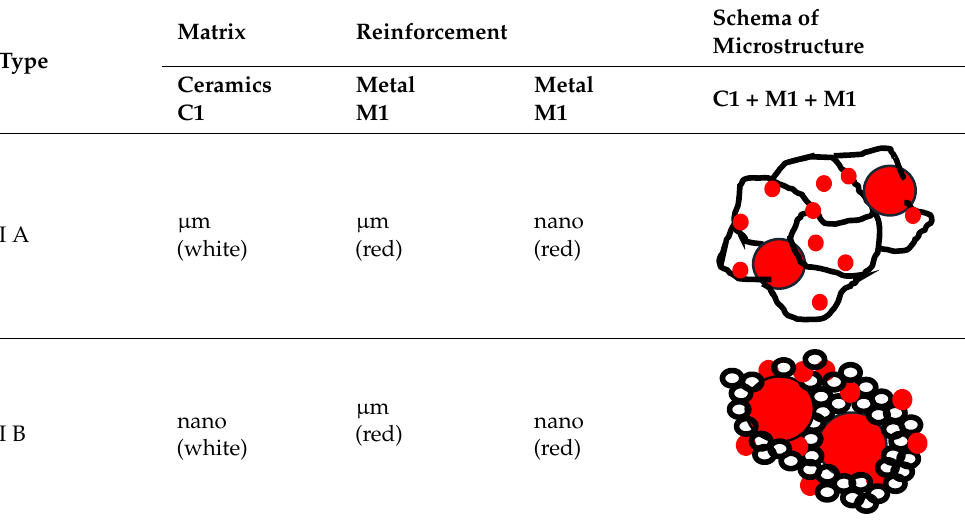
Table 1. Types of microstructures of ceramic–metal composites fabricated by consolidation of pow- ders, one ceramic and one metal with various variants of ceramic and metal powder size and their geometrical schemas.